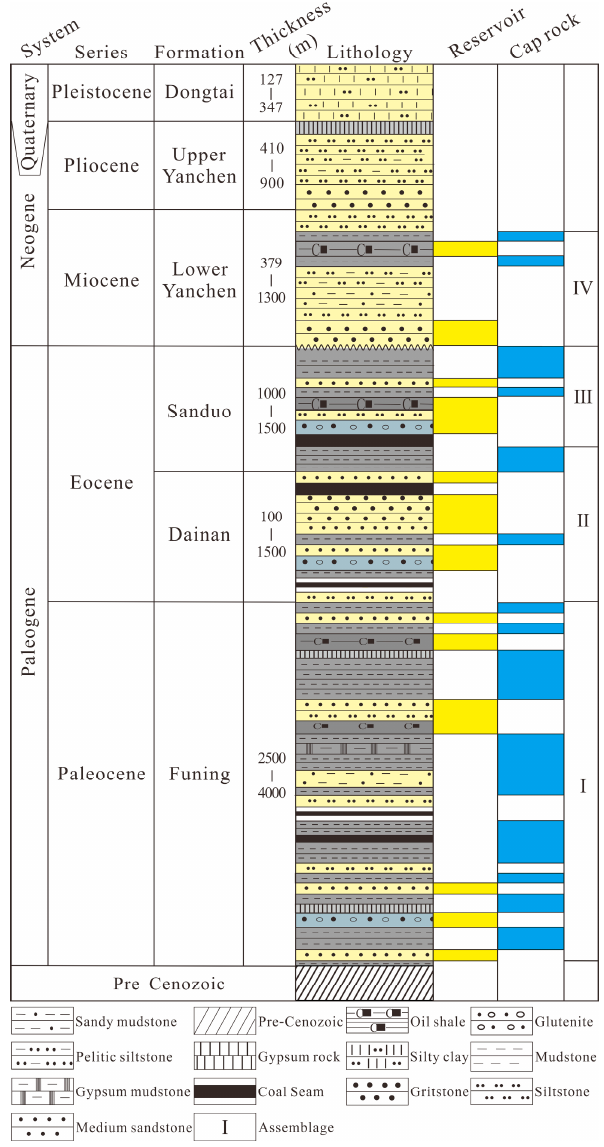
Figure 2. Stratigraphic column of Cenozoic strata in the South Yellow Sea Basin. Faults in the SYSB are predominantly oriented in NE, NNE, or approximately EW and NW directions, and can be divided into three faulting periods: the Caledonian, Indosinian, and Yanshan–Xishan [47,48,51]. Faults in the Caledonian period were predominantly NE- oriented and exhibited weak activity, which led to folding during the Lower Paleozoic.